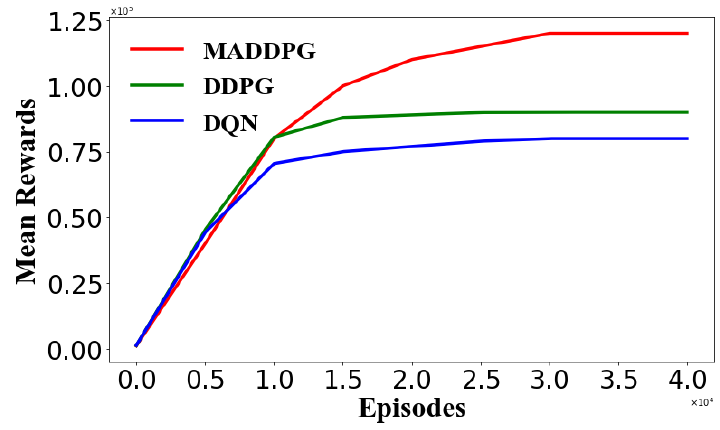
Figure 14. Convergence of the cumulative mean rewards.